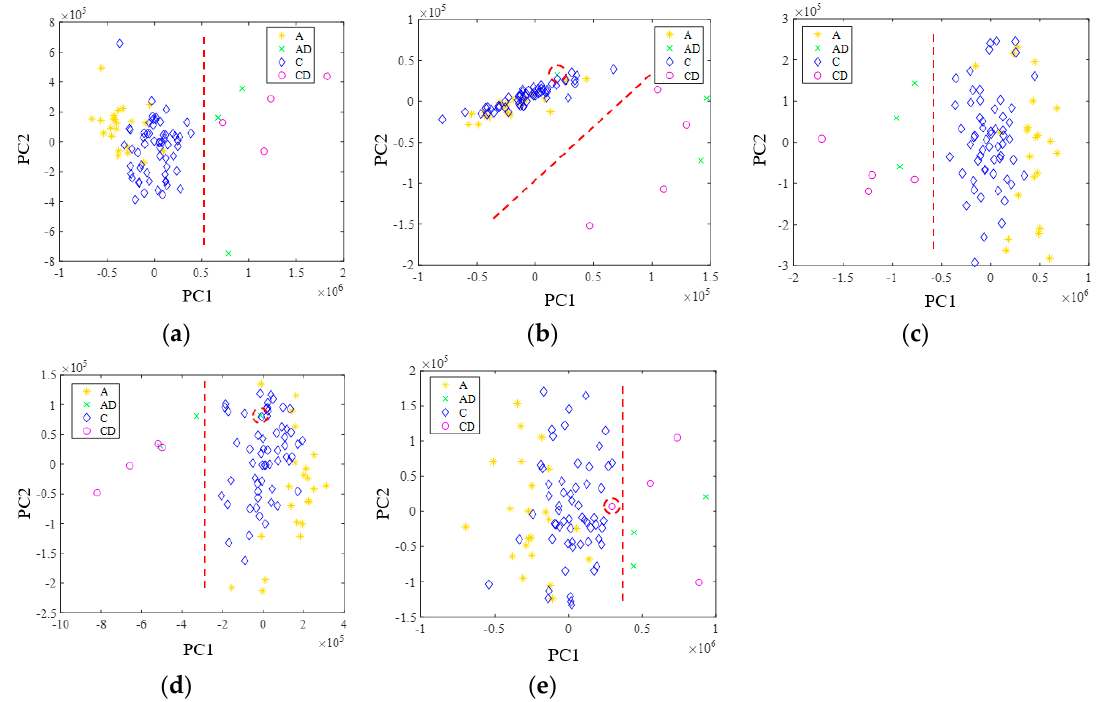
Figure 11. 2D plot according to division of frequency range using principal component: ( a ) feature set A (0–10 kHz); ( b ) feature set B (0–4 kHz); ( c ) feature set C (4–10 kHz); ( d ) feature set D (4–7 kHz); ( e ) feature set E (7–10 kHz).